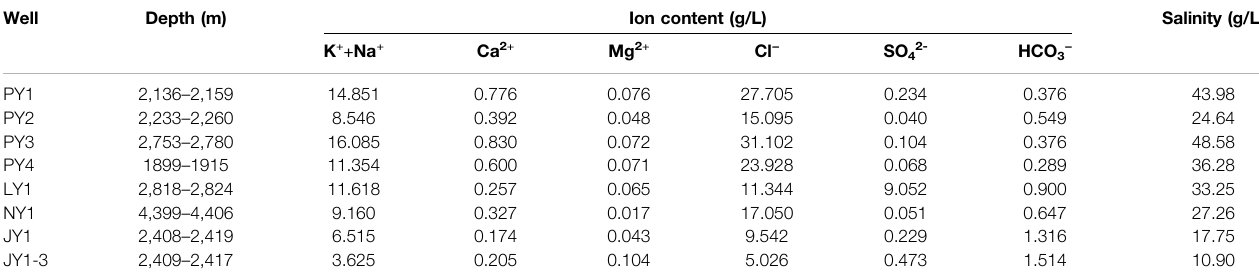
TABLE 2 | Statistics of average ion content and salinity of formation water of Wufeng-Longmaxi Formation in Sichuan Basin. Well Depth (m) Ion content